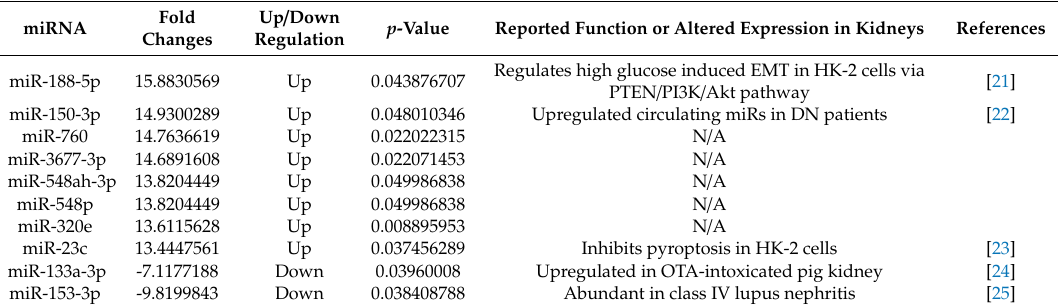
Table 2. MicroRNAs (miRs) with the highest fold change in expression levels in nephroticdiabetic nephropathy (DN) patients.